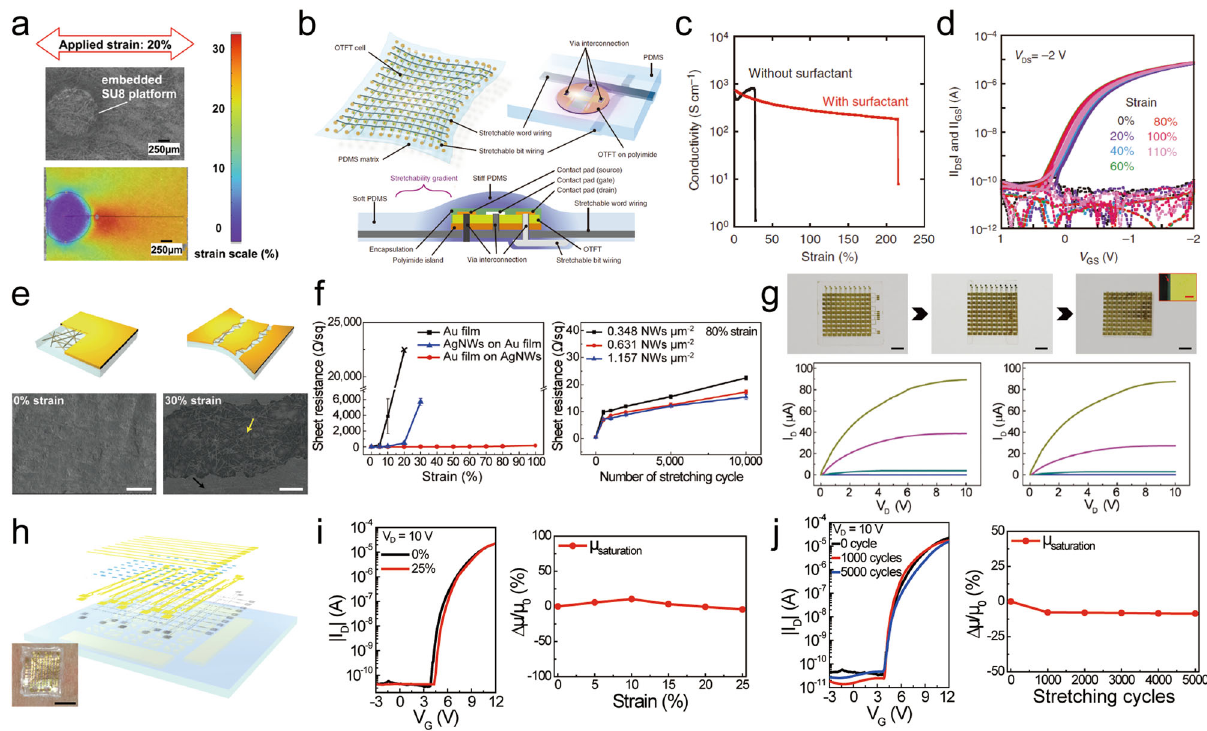
Fig. 3 Device islands-interconnect design for highly fl exible TFT backplane. a Simulation of strain manipulation at the top surface of the engineered substrate. Reproduced with permission from ref. 9. Copyright 2013, American Institute of Physics. b Schematic illustrations of OTFT backplane on engineered substrate. c Conductivity dependence on tensile strain in printed elastic conductors with and without surfactant. d Transfer characteristics of OTFT according to the tensile strain. b – d Reproduced with permission from ref. 12. Copyright 2015, Nature Publishing Group. e Schematic images ( top ) and scanning electron micrographs ( bottom ) of stretchable conductor (Au fi lm on AgNWs- embedded elastomer) before and after stretching. Scale bars : 5 μ m. f Resistance dependence on tensile strain ( left ) and cyclic numbers ( right ) of the stretchable conductor (Au fi lm on AgNWs-embedded elastomer). g Images ( top ) and output characteristics ( bottom ) of foldable TFT backplane on engineered substrate before and after folding. Scale bars : 5 mm ( black ) and 100 μ m ( red ). e – g Reproduced with permission from ref. 13. Copyright 2016, Royal Society of Chemistry. h Illustration and photograph ( inset ) of stretchable TFT backplane on engineered substrate. i Electrical properties of device in h according to the mechanical strain (up to a strain of 25%). j Electrical properties of device in h according to the number of